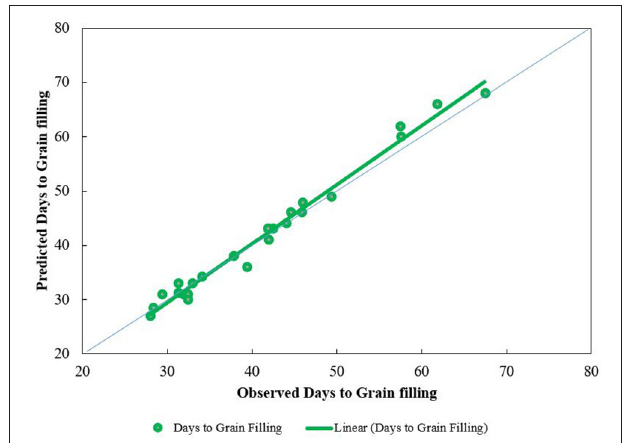
FIGURE 7 | Trend lines for predicted vs. observed number of days from anthesis to maturity for four sowing dates at the three study sites during 2 years. Predictions are based on the Wang and Engel algorithm (Equation 1) modified by photoperiod effect (Equation 3), the latter using a photoperiod coefficient of 2.